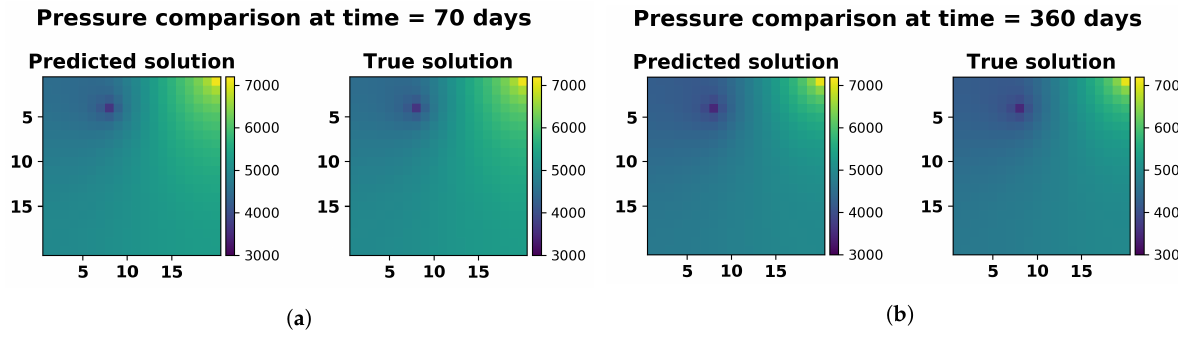
Figure 14. Pressure solution comparison at ( a ) Time = 70 days and ( b ) Time = 360 days.